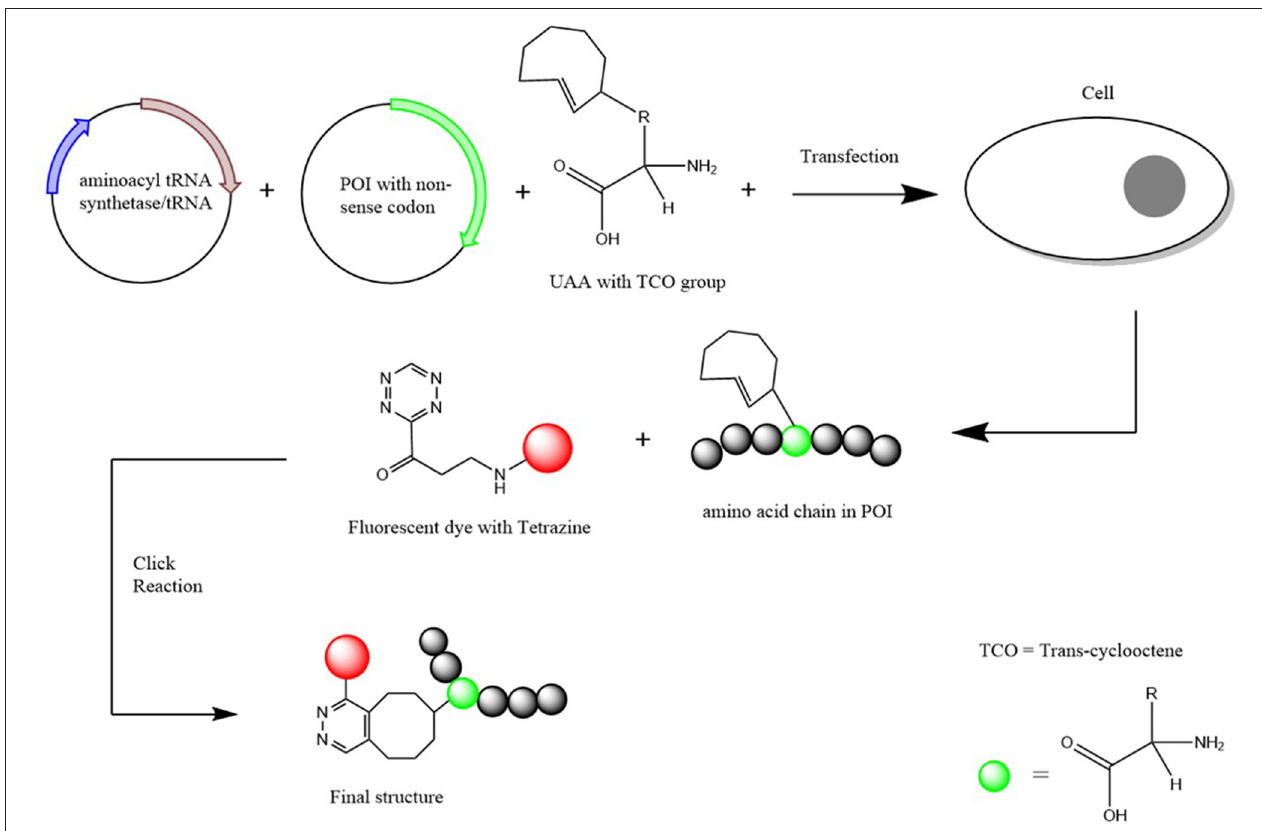
FIGURE 2 | Schematic Diagram of how an UAA is incorporated into a protein of interest. Two plasmids (one containing the aminoacyl-tRNA synthetase and the other the POI with the non-sense codon inserted) and the UAA with a TCO group attached are transfected into the chosen cells. Once incorporated, a fluorescent dye with a tetrazine group is added for the click chemical reaction to result in a structure that attaches the POI with the fluorescent dye together. Scheme based on Niki ´ c et al.